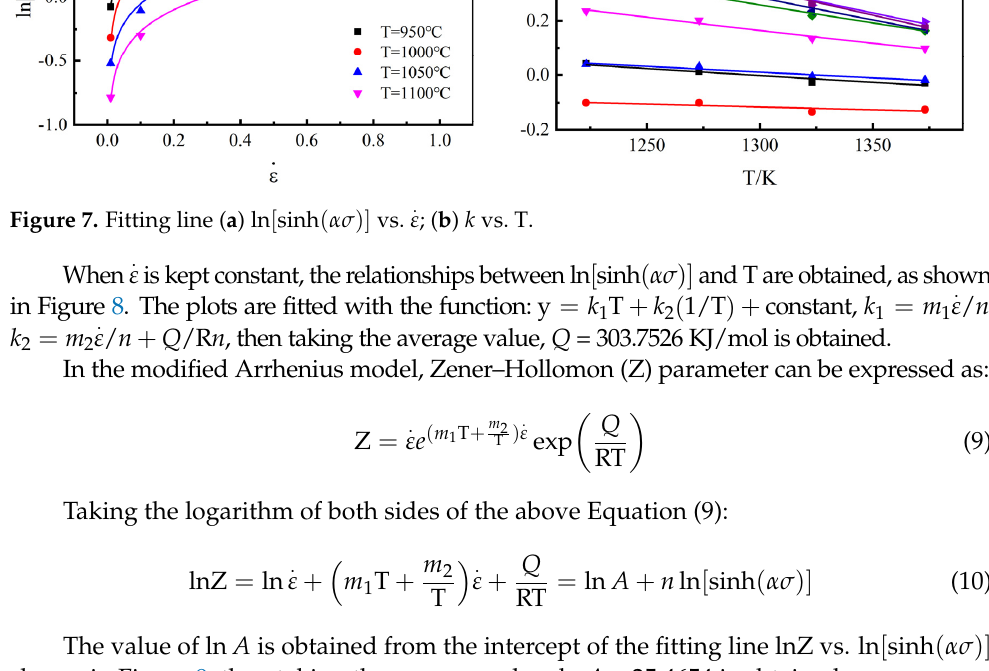
Figure 8. Fitting line, ln(cid:4670)sinh(𝛼𝜎)(cid:4671) vs. T . In the modified Arrhenius model, Zener–Hollomon (Z) parameter can be expressed as: